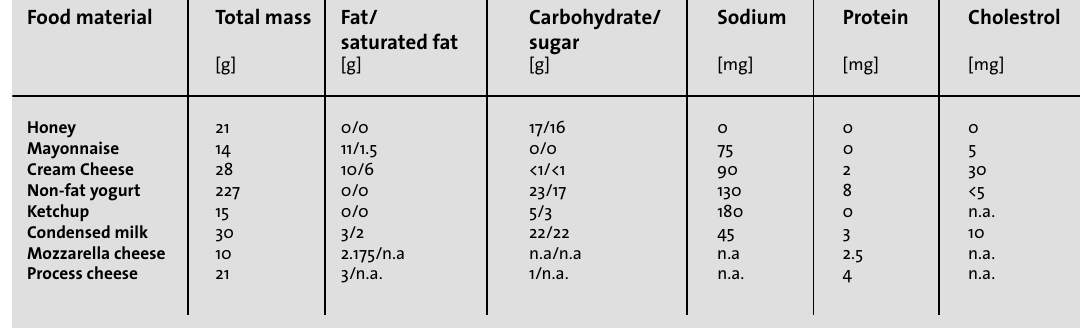
Table 1: Composition of store-bought food materials tested (the composition data presented were obtained from product label).